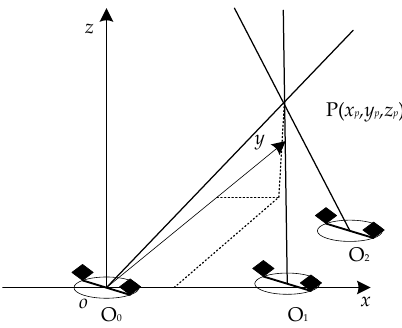
Figure 3. The localization principle for one PD source with multi-PD source.